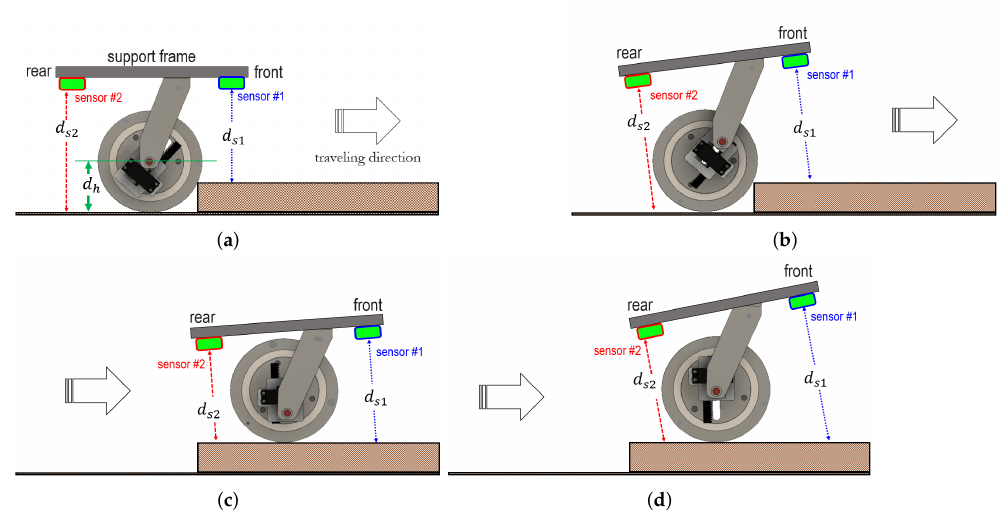
Figure 22. Illustration of experiments to investigate the inclination of the support frame by axle translation and its control possibility by electronic parts. ( a ) State-1: contact with the step, ( b ) state-2: axle translation, ( c ) state-3: step ascending, ( d ) state-4: returning to original axle